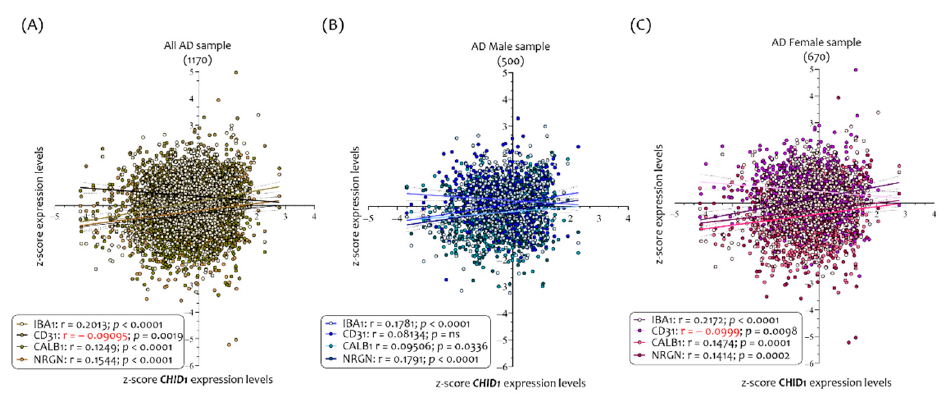
Figure 5. Correlation analysis between CHID1 brain expression levels and neurological markers in AD patients. Analysis of correlation between the CHID1 , IBA1 , CD31, CALB1 , and NRGN expression levels in all brains (1170) ( A ), and in brains sorted in 500 males ( B ) and 670 females ( C ), belonging to AD patients. Data in the figure are indicated as z-score intensity expression levels and presented graphically as dot plots. p values < 0.05 were considered to be statistically significant.